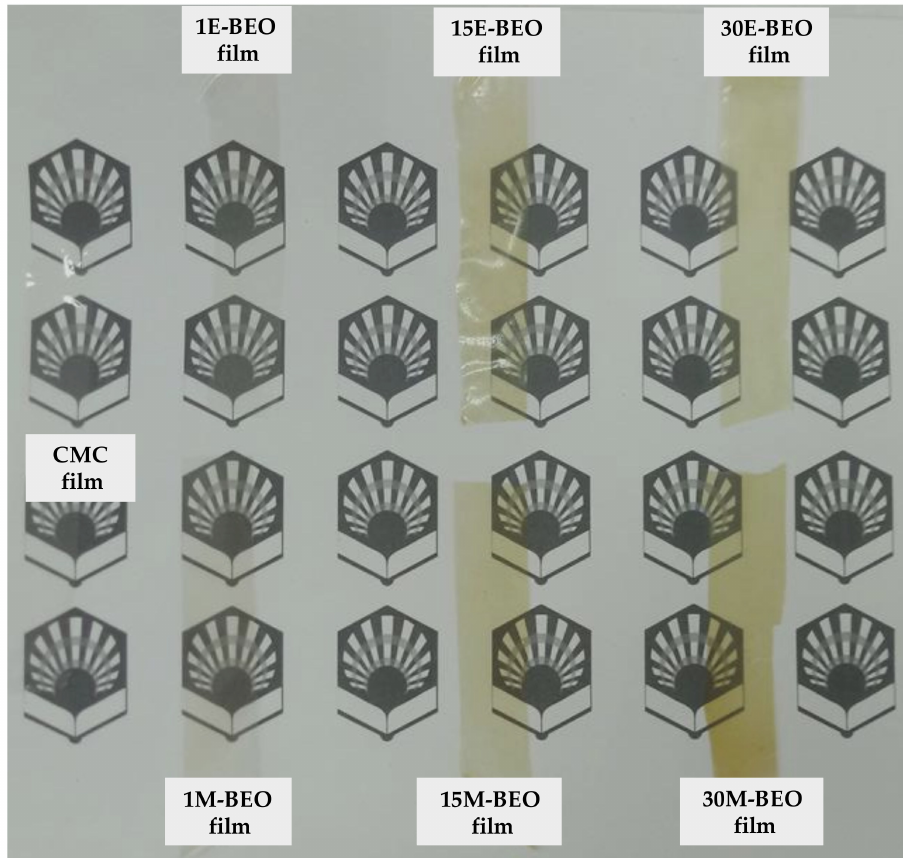
Figure 6. CMC films formulated with di ff erent concentrations of